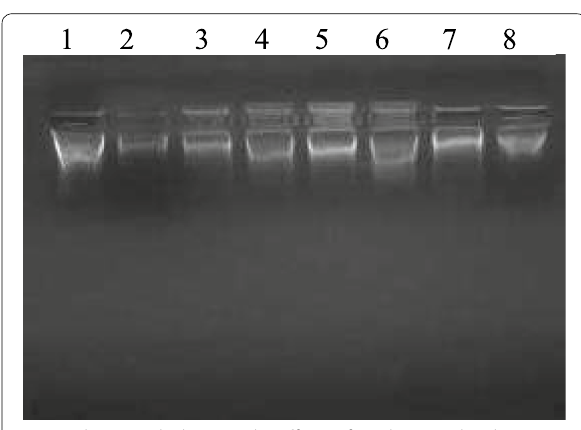
Fig. 2 Photograph showing the effects of synthetic molecules on calf thymus DNA. Lane 1: Untreated DNA, lane 2: 10a , lane 3: 10b , lane 4: 10c , lane 5: 10d , lane 6: 14a , lane7: 14b lane 8: 14c